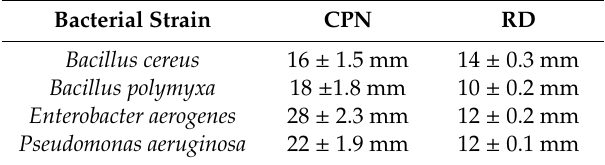
Table 6. Zone of inhibition (ZoI) for RD vs. CPN with standard